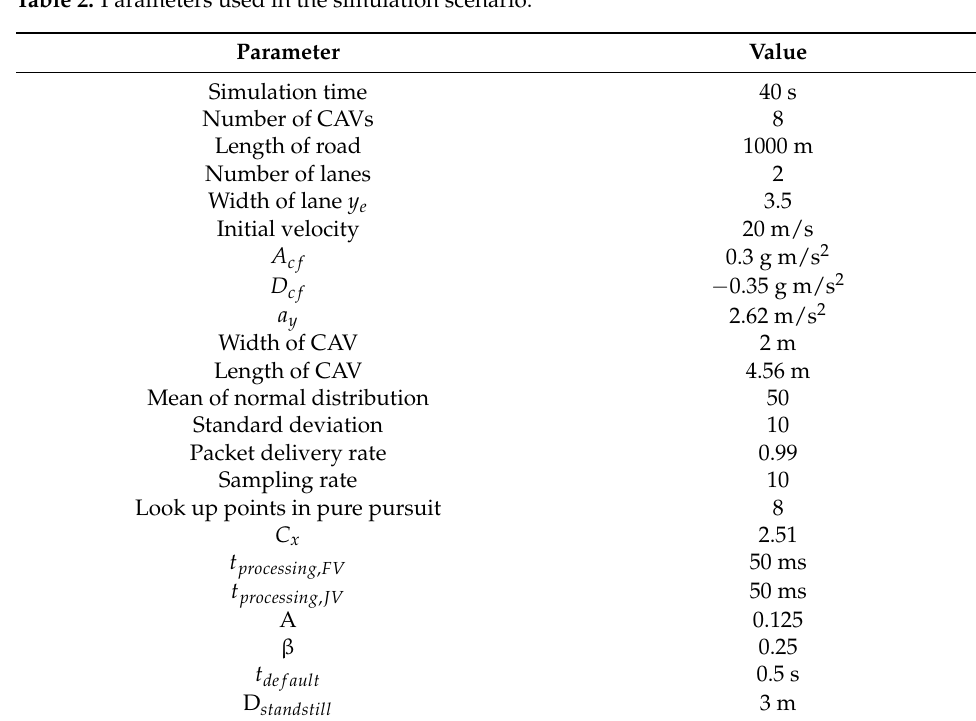
Figure 7. Platooning system model implemented in simulator PreScan. Table 2. Parameters used in the simulation